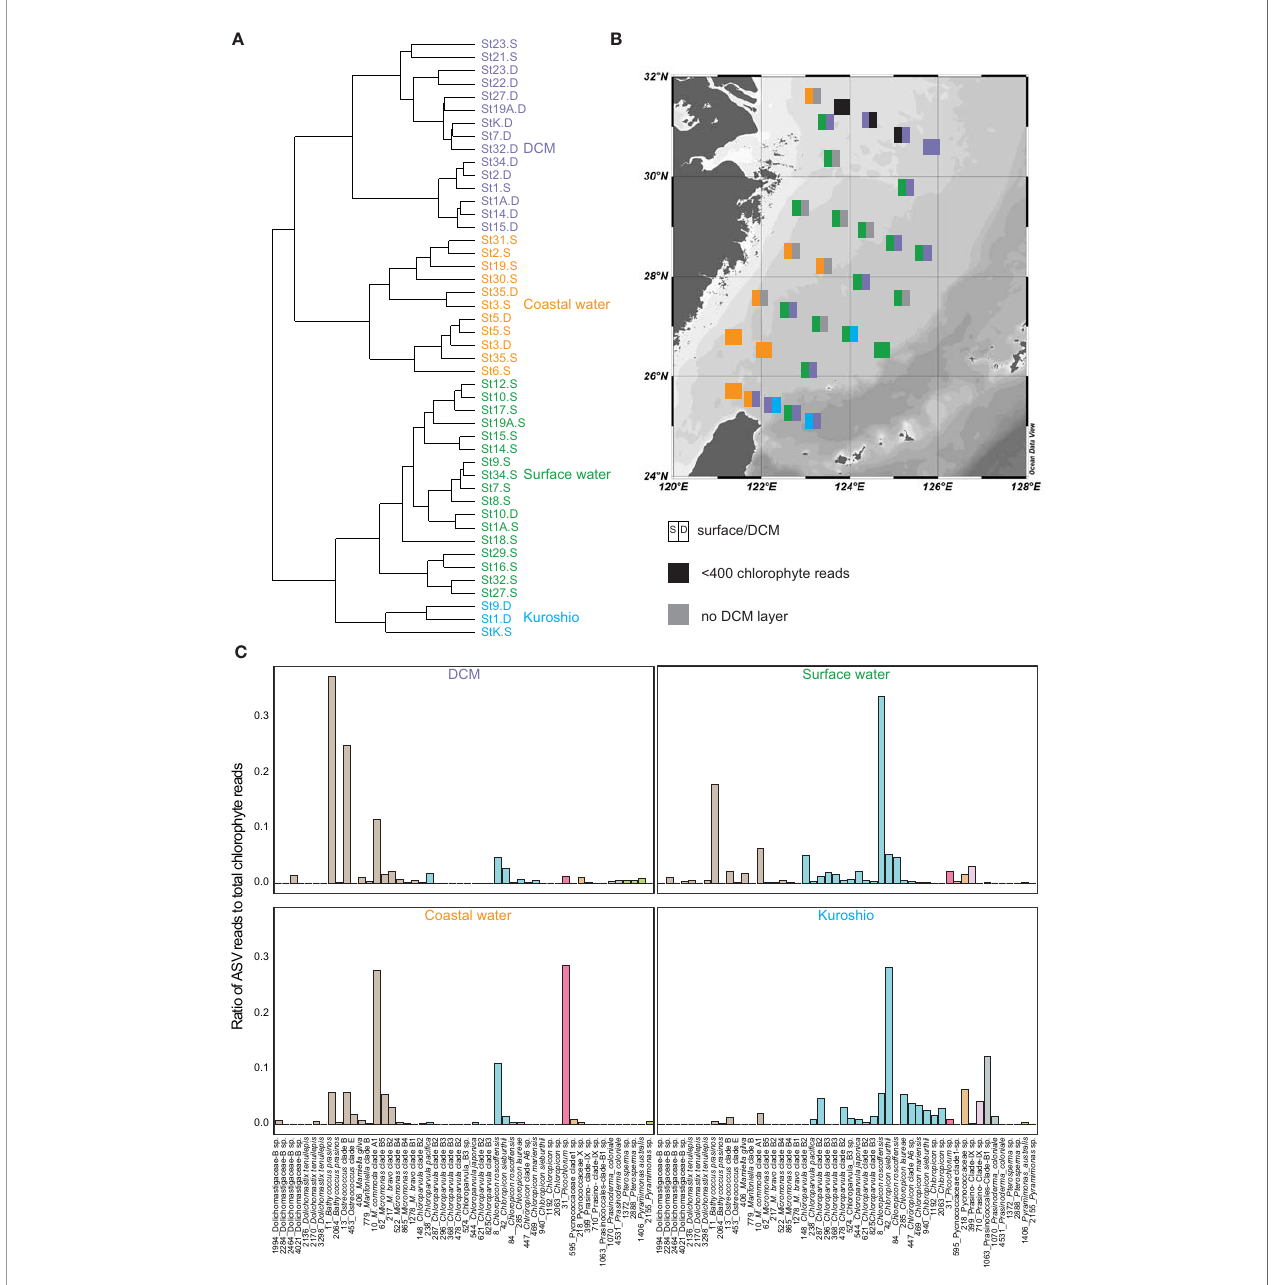
FIGURE 5 | (A) The four clusters generated by hierarchical clustering of chlorophyte ASV table after subsampling. (B) The colors in squares represent the clusters from (A) . The left and right half of each square represent surface and DCM samples, respectively. Black shows chlorophyte reads < 400 in amplicon data while grey indicates that no DCM layer was observed at that station. (C) The average fraction of total chlorophyte amplicon in each cluster for the 50 most abundant chlorophyte ASVs. The colors indicate the distinct classes and the numbers next to the taxonomic annotations indicate the